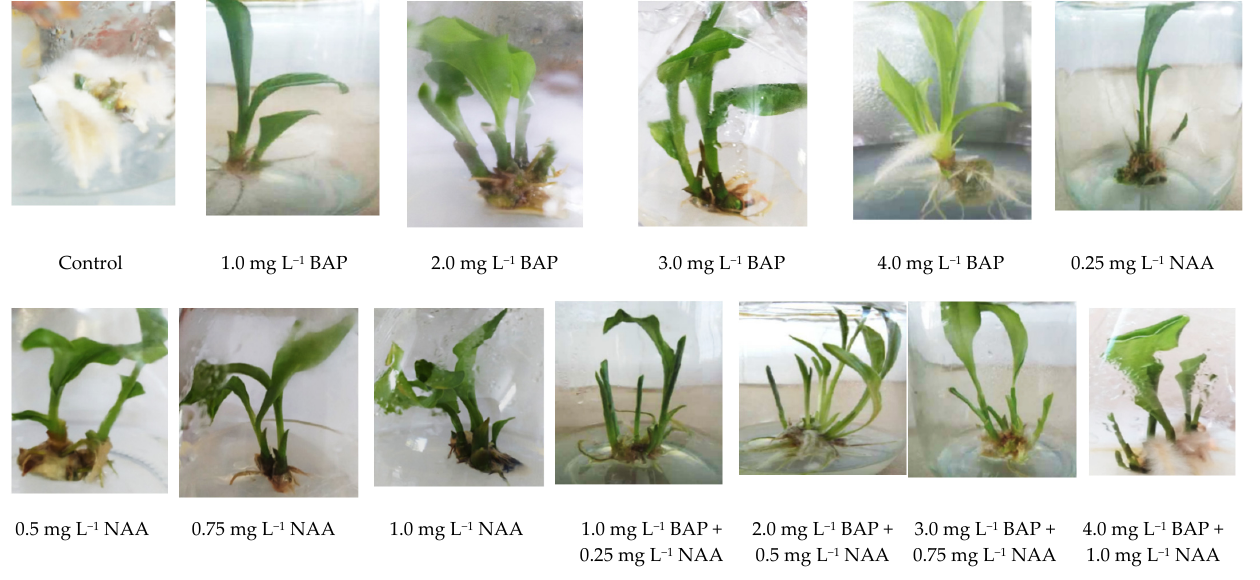
Figure 3. Stahlianthus thorelii Gagnep’s rapid in vitro proliferation and the effect of growth regula-